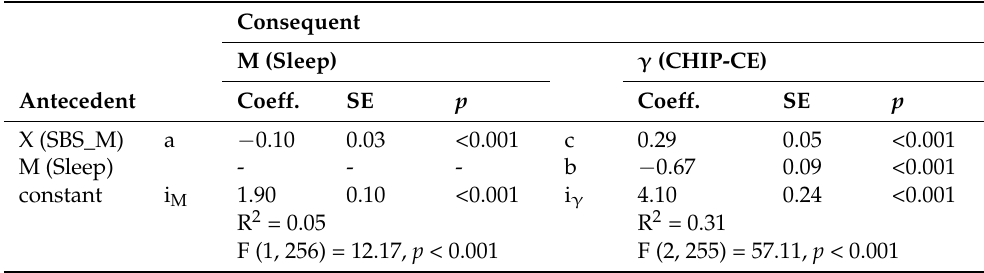
Table 3. Mediation effect of the sleep quality in the link between secure base support from the mother (SBS_M) and overall well-being.